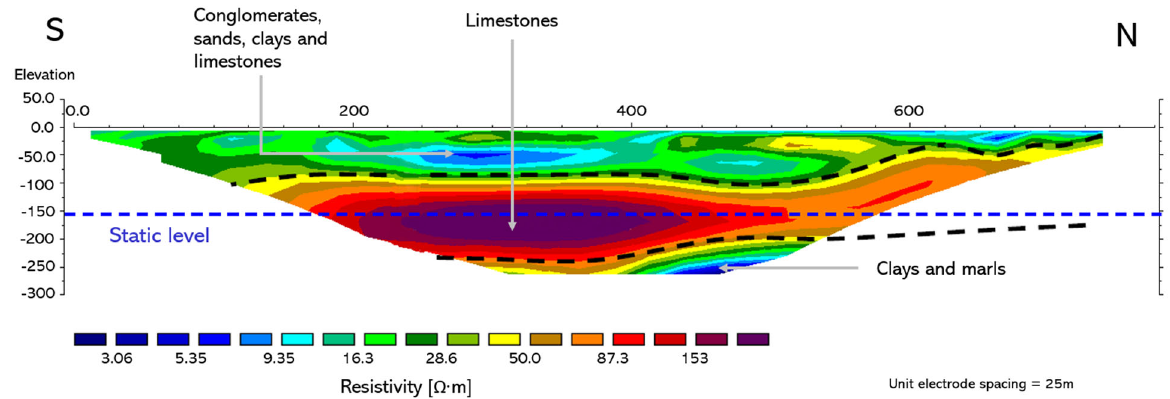
Figure 6. 2D electrical tomography profile for study Case 2, Alicante.